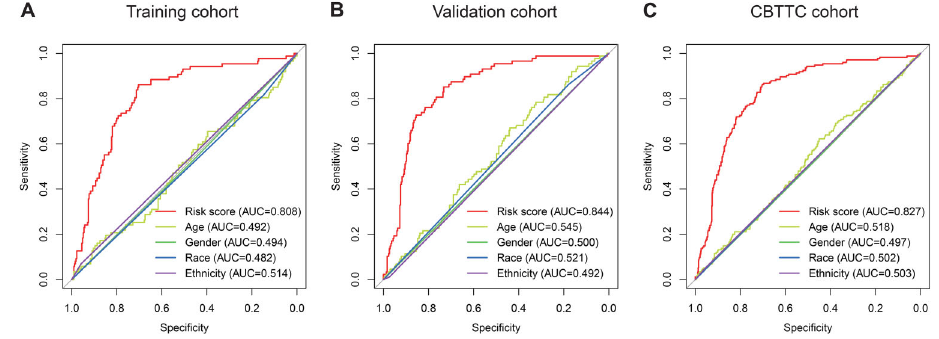
Figure 6. Receiver operating characteristic (ROC) analysis of the eight-gene signature risk score. ROC analysis of the sensitivity and speci fi city of the overall survival prediction by the eight-gene risk score, age, gender, race, and ethnicity in the training ( A ), validation ( B ), and Pediatric Brain Tumor Atlas (CBTTC) ( C ) cohorts. AUC: area under the ROC